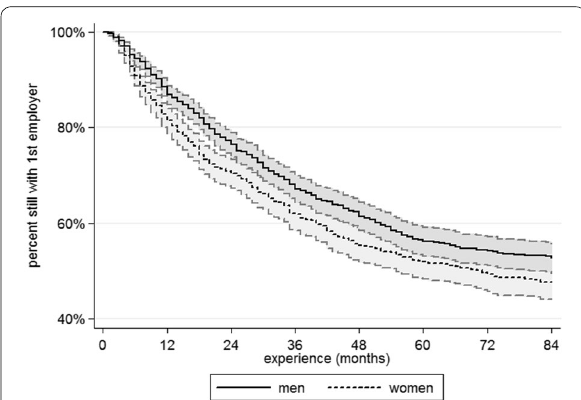
Fig. 3 Gender-specific job mobility: time course of first employer change and 95% CIs ( Source BAP 2005/06, author’s calculations; cre- ated with Stata13)